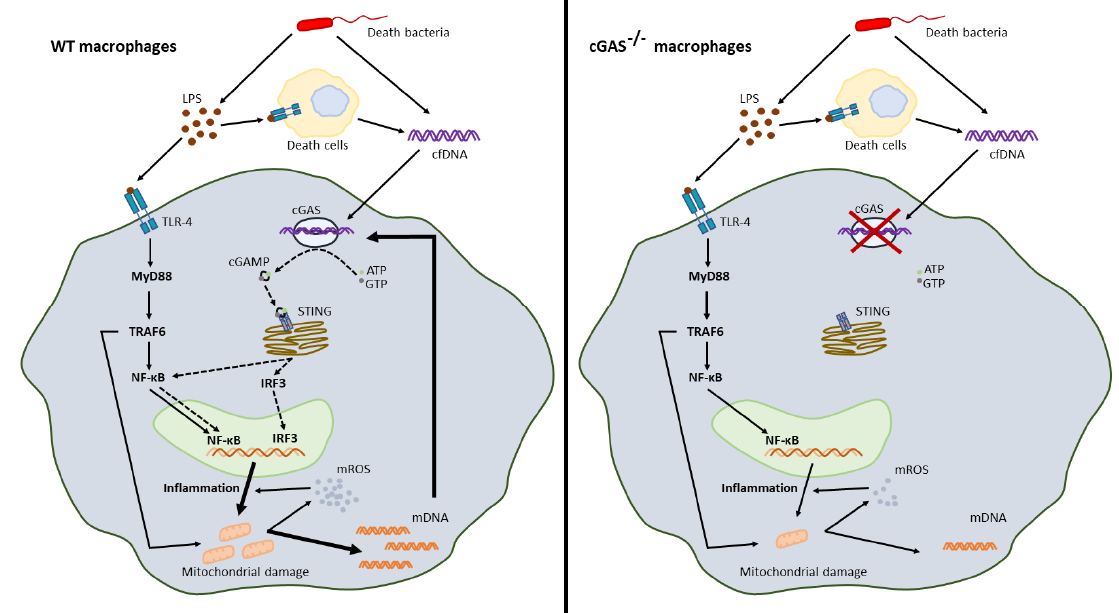
Figure 8. The working hypothesis demonstrates the synergy between lipopolysaccharide (LPS) and cell free DNA (cfDNA); bacterial DNA and host DNA (from LPS-induced cell death), through TLR-4 and cyclic GMP–AMP synthase (cGAS). In WT macrophages, LPS with cfDNA activated a severe inflammation through TLR-4 (MyD88, TRAF6 and NF- κ B) and cGAS (cGAMP generation, STIN, and IRF-3), causing mitochondrial DNA (mtDNA) release that also activated cGAS and induced further inflammation ( left-hand image ). Additionally, mitochondrial reactive oxygen species (mtROS) also increased inflammation. Without cGAS, there was a less prominent inflammation that caused less mtDNA to be released and an absence of mtDNA-induced cGAS resulted in lower inflammatory responses in cGAS deficient macrophages compared with WT cells ( right-hand image ). Hence, a vicious cycle of cGAS activation-induced mitochondrial damage ensued, mtDNA further facilitating inflammation-induced mitochondrial injury which we suggest might have enhanced LPS responses. ATP, adenosine triphosphate; GTP, guanosine triphosphate; cGAMP, cyclic guanosine–adenosine monophosphate (GMP–AMP); MyD88, myeloid differentiation primary response 88; TRAF6, TNF receptor associated factor 6; NF- κ B, nuclear factor kappa-light-chain-enhancer of activated B cells; IRF3, interferon regulatory factor 3; STING, stimulator of interferon genes; mtROS, mitochondrial reactive oxygen species.